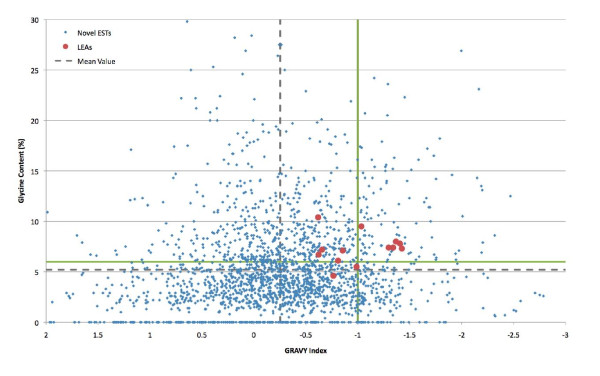
Plot of the putative glycine content and the hydropathy of the protein sequences encoded by the novel ESTs and putative LEA proteins in the P. superbus dataset. Green lines represent the boundaries of the properties that define hydrophilins; glycine content > 6% and a hydropathicity index of < -1 [154].